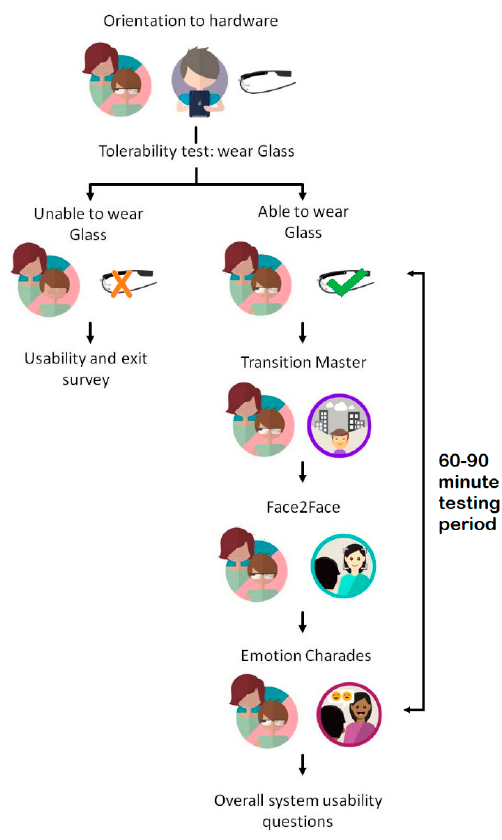
Figure 6. Outline of Phases of Study, including orientation to hardware, initial tolerability test of 1- minute duration, followed by 60–90 min multi-module testing period.